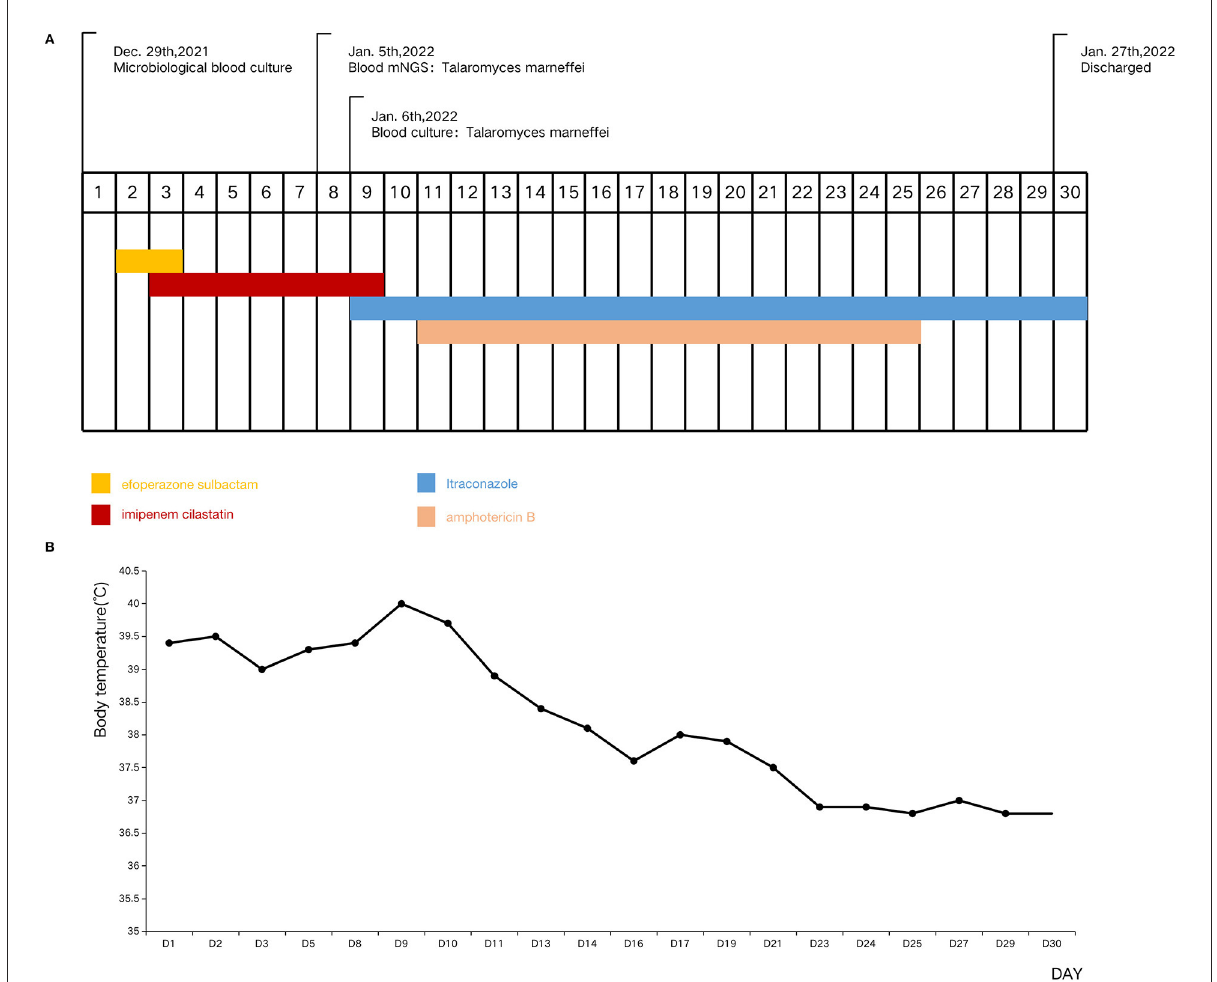
FIGURE1 Timeline of the patient’s clinical manifestations and treatment. (A) Timeline of the patient’s tests and treatment. (B) Timeline of the patient’s body temperature.